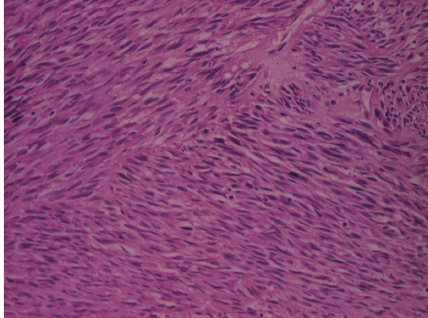
Figure 5: Spindle cells arranged in fascicles and showing mild nuclear pleomorphism and mitotic activity (100x